Question: Provide a one-line summary of what is displayed.
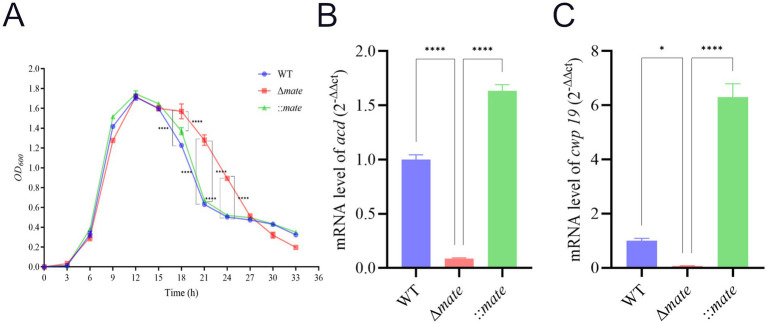
Answer: Bacterial growth of WT, ∆ mate and :: mate strains. (A) Growth curves of WT, ∆ mate and :: mate strains. The horizontal axis represents incubation time (hours), and the vertical axis represents cell turbidity at OD 600 . (B,C) The mRNA expression levels of the acd and cwp19 genes in WT, ∆ mate and :: mate strains. Data were presented as mean ± SEM. Statistical significance was determined using one-way ANOVA, followed by Dunnett’s post hoc test. * P < 0.05, **** P < 0.0001.